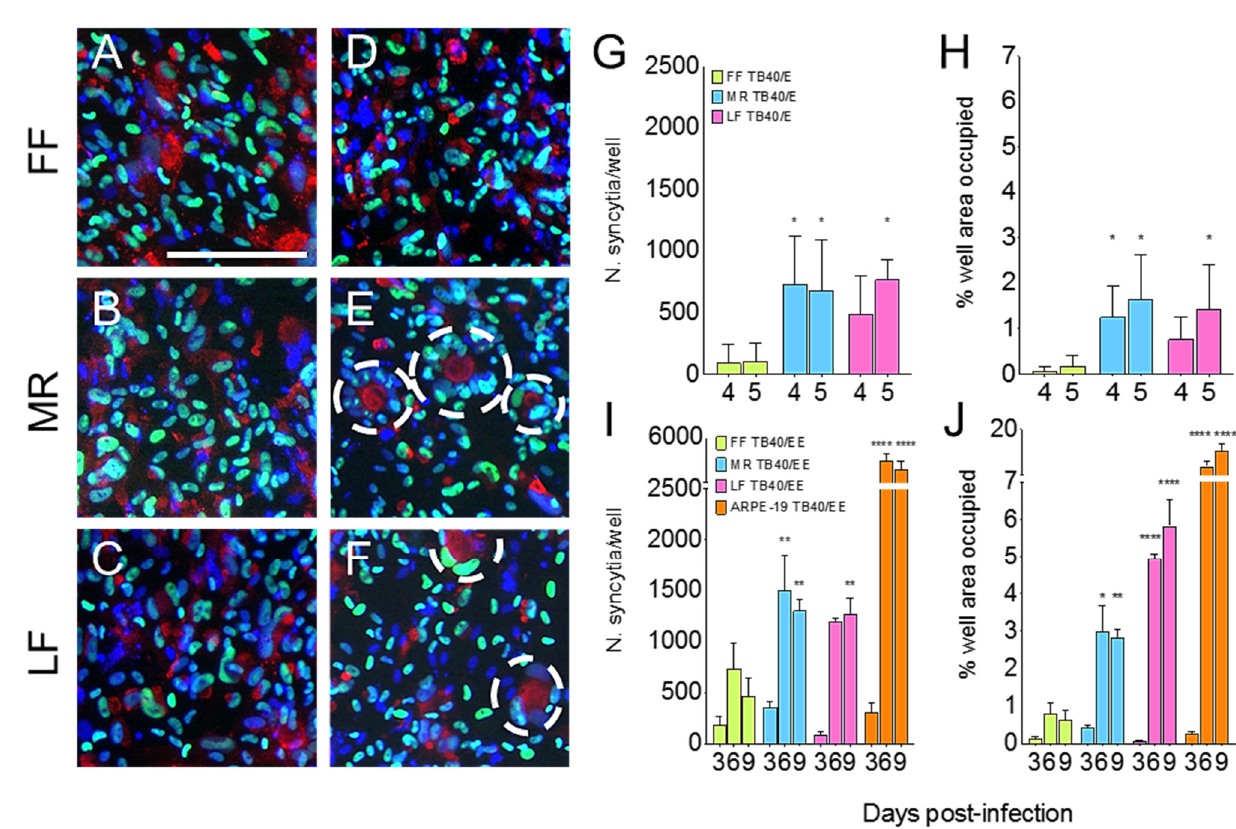
Figure 3. Syncytia formation in FF, MR, and LF cells infected with AD169, TB40/E, or TB40/EE. ( A – F ) Representative microscopy images of cells exposed to AD169 ( A – C ) or to TB40/E ( D – F ) virions at an MOI of 0.01 pfu/cell and stained for the viral IE1/IE2 proteins (green) and for the viral pp28 protein (red) at day nine post-infection. Dashed lines encircle syncytia. Bar = 200 μ m. ( G – J ) Number (N.) of syncytia/well or calculated percentage of well area occupied by syncytia in fibroblast or ARPE-19 epithelial cell monolayers cultured in 24-well plates and exposed to TB40/E virions at an MOI of 0.5 ( G , H ) or TB40/EE virions at an MOI of 0.1 ( I , J ) pfu/cell. Mean and standard deviation values of counts obtained by two different individuals from at least four separate micrographs in a single experiment per strain are shown. * = p value > 0.01; ** = p value > 0.001; **** = p value < 0.0001 as determined by two-way ANOVA comparing LF or MR means to FF or ARPE-19 means.